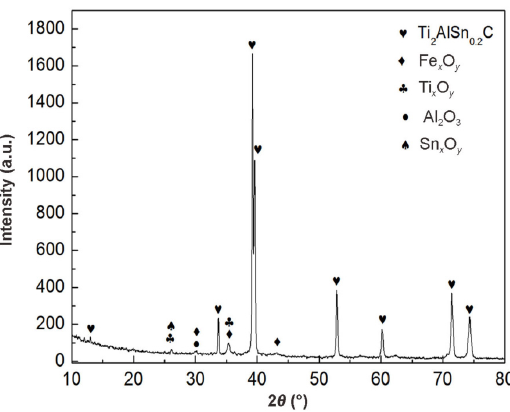
Fig. 10 XRD pattern of the Ti 2 AlSn 0.2 C friction surface after 36,000 m (three continues processes) at 30 m/s and 80